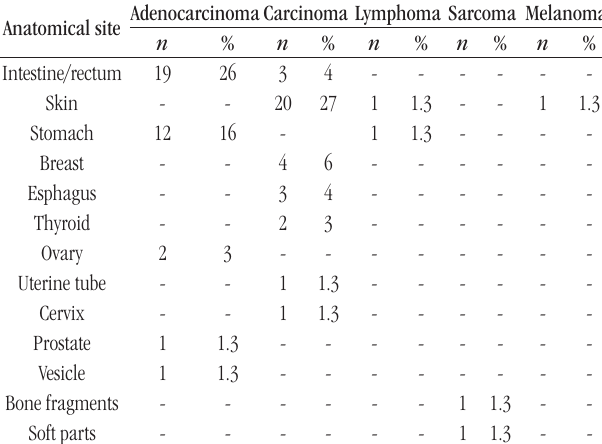
taBLE 1 − Determination of histological types according to the anatomical sites of the malignant tumors Adenocarcinoma Carcinoma Lymphoma Sarcoma Anatomical site